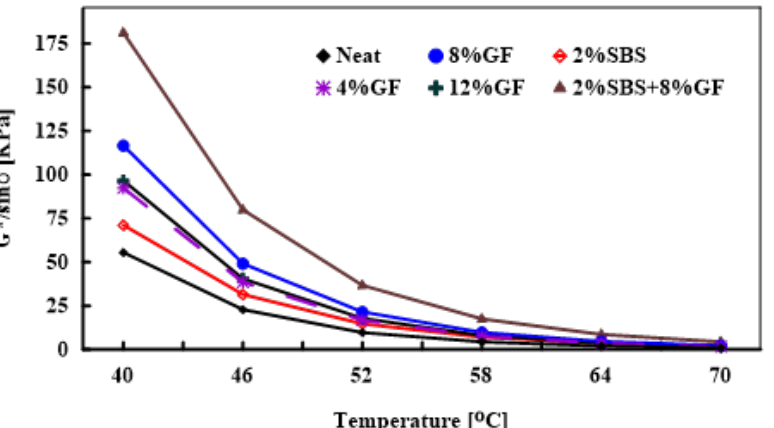
Figure 6. Temperature’s effect on the rutting factors of neat and modified asphalt binders at 10